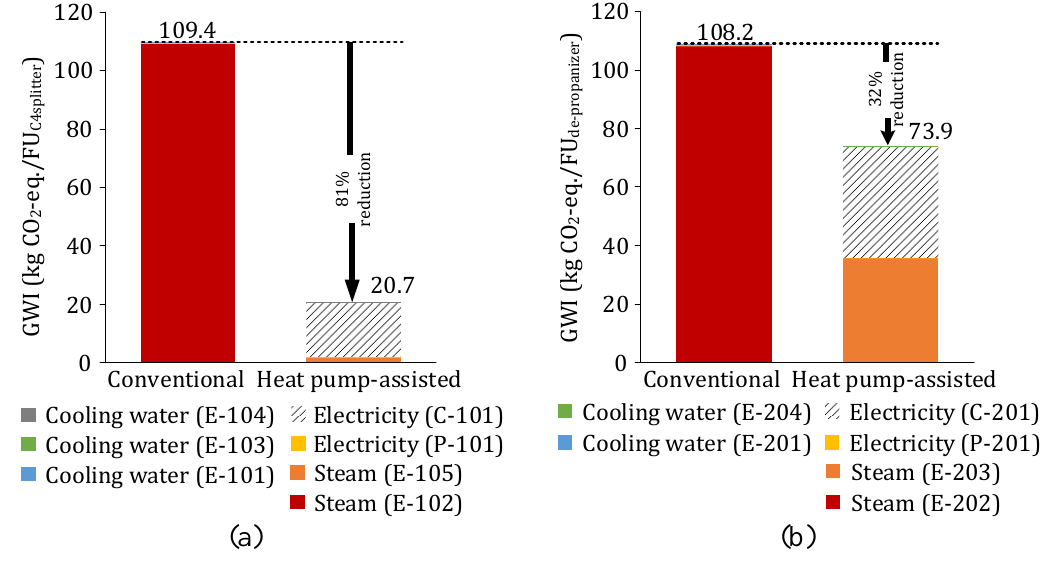
Figure 7. GWI (Global warming impact) in kg CO 2 -equivalents (kg CO 2 -eq.) per functional unit (FU) for ( a ) a C4 splitter in conventional distillation (left) and heat pump-assisted distillation (right), and ( b ) a de-propanizer in conventional distillation (left) and heat pump-assisted distillation (right).